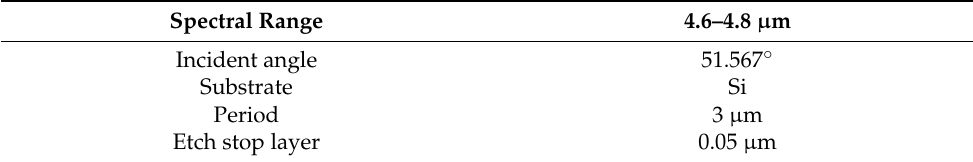
Table 2. Parameter of reflective grating.